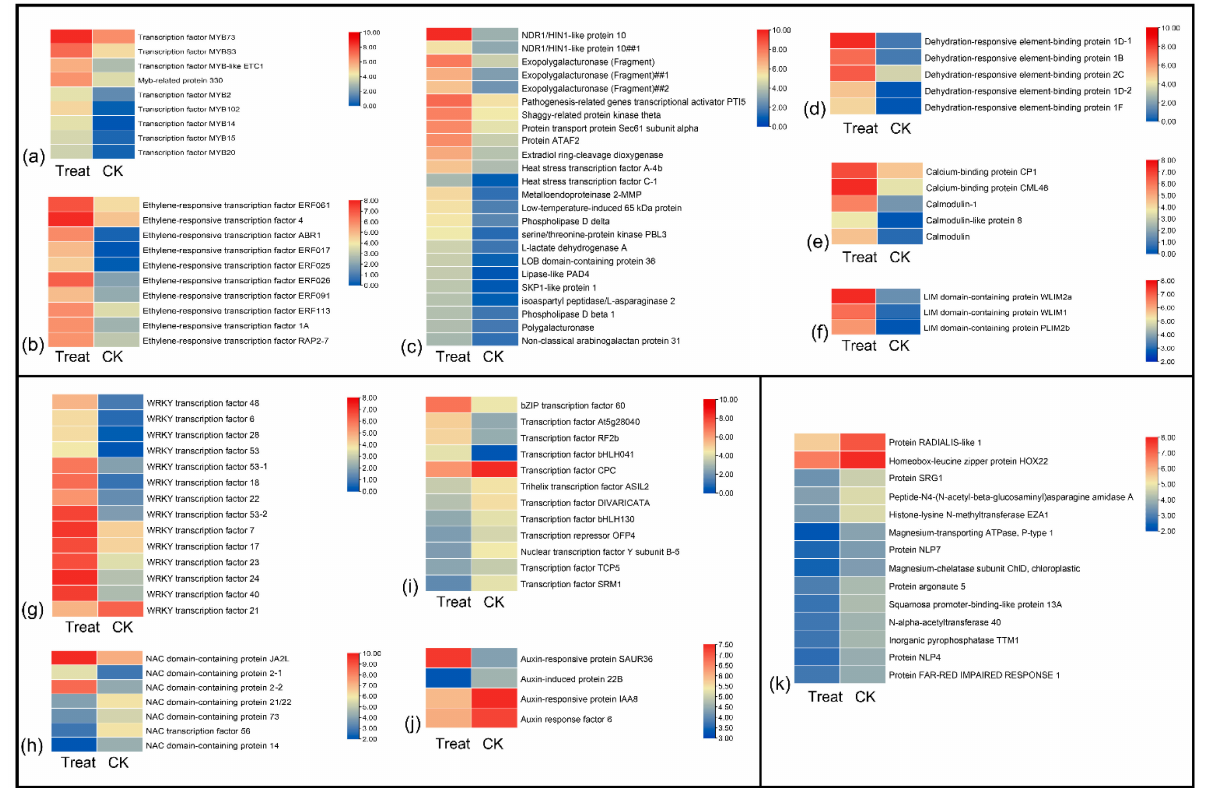
Figure 4. The heatmap of major regulator genes response to low temperatures in P. mume. ( a – f ) Up- regulated genes after cold stress, including MYB family, ethylene-responsive transcription